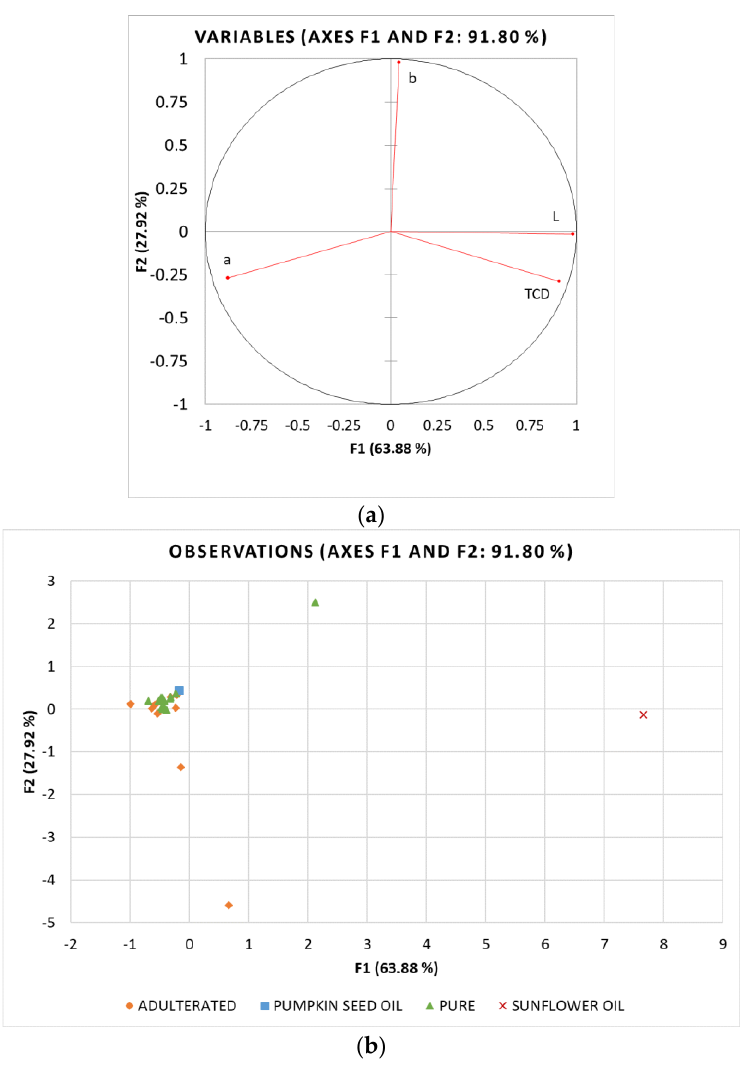
Figure 5. Principal component analysis (PCA) of colourimetric data: Projection of ( a ) active variables and ( b ) oil samples (SO_1–25—commercial oils labelled as pumpkin seed oil, laboratory pumpkin seed oil and refined sunflower oil) on the factorial plane (F1×F2).